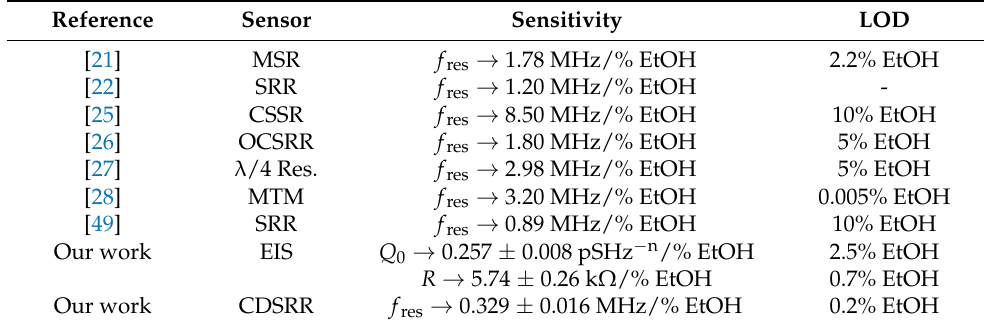
Table 1. Values of sensitivity and LOD of our EIS sensor and CDSRR, and comparison with other water/ethanol fluidic sensors in the